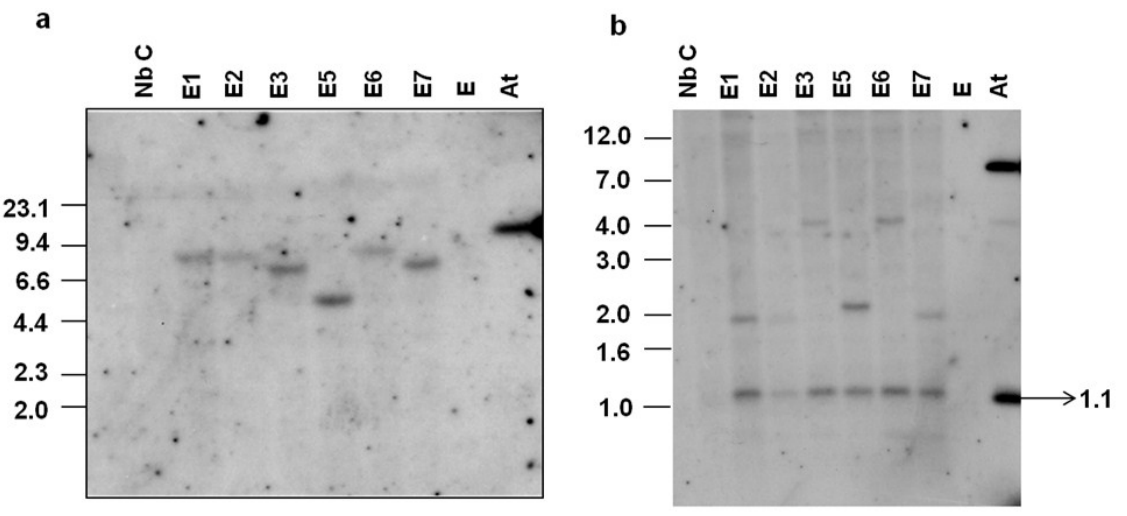
Figure 1. T-DNA of the binary vector pCAM- v irE2 [22]. LB, left T-DNA border; RB, right T-DNA border; P35S, Cauliflower mosaic virus (CaMV) 35S promoter; 35S 3’, CaMV 35S polyadenylation signal; hpt , hygromycin phosphotransferase gene; int, intron; nos3’, nopaline synthase polyadenylaton signal. Junction fragments ( > 2.2 kb and >1.3 kb) and internal T-DNA fragment (1.1 kb) are shown in dotted lines. Bold lines represent the region of hpt and virE2 genes which were used as probes.